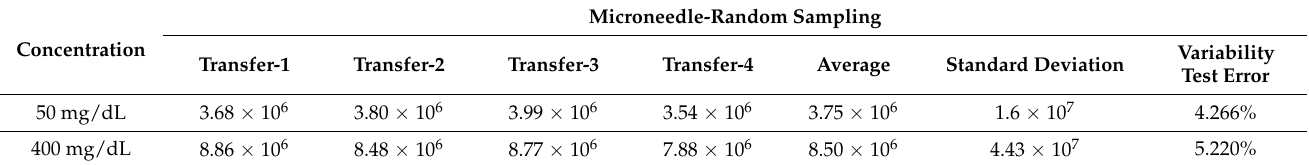
Table 3. Micro-transfer variability test error.